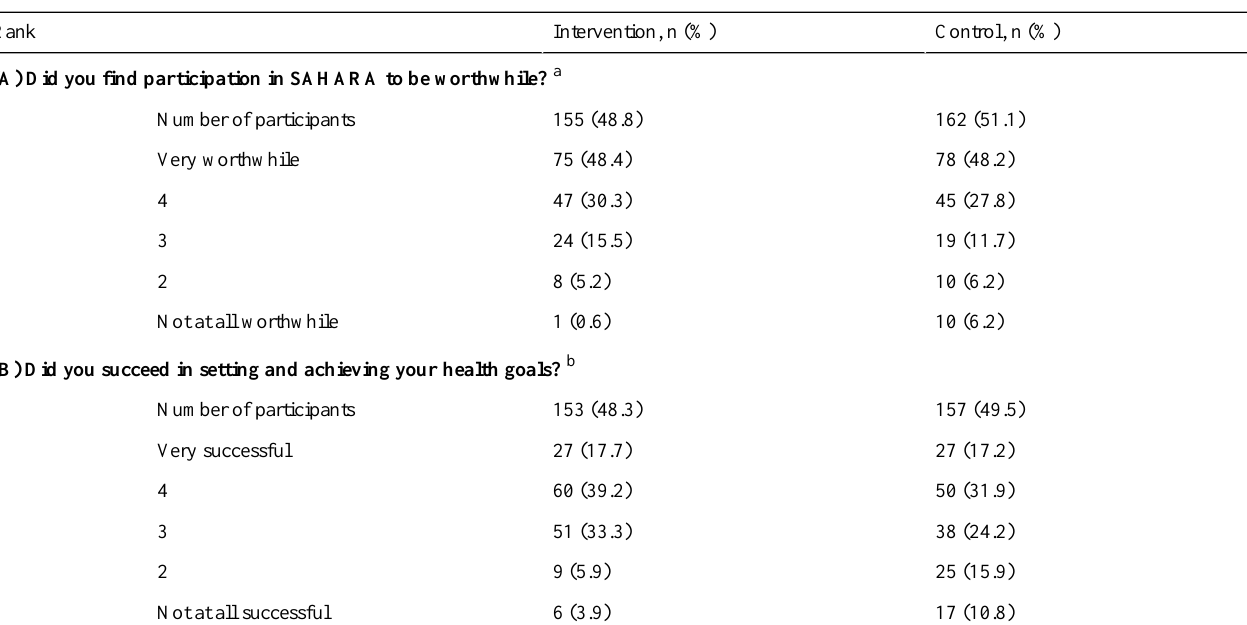
Table 7. Exit survey